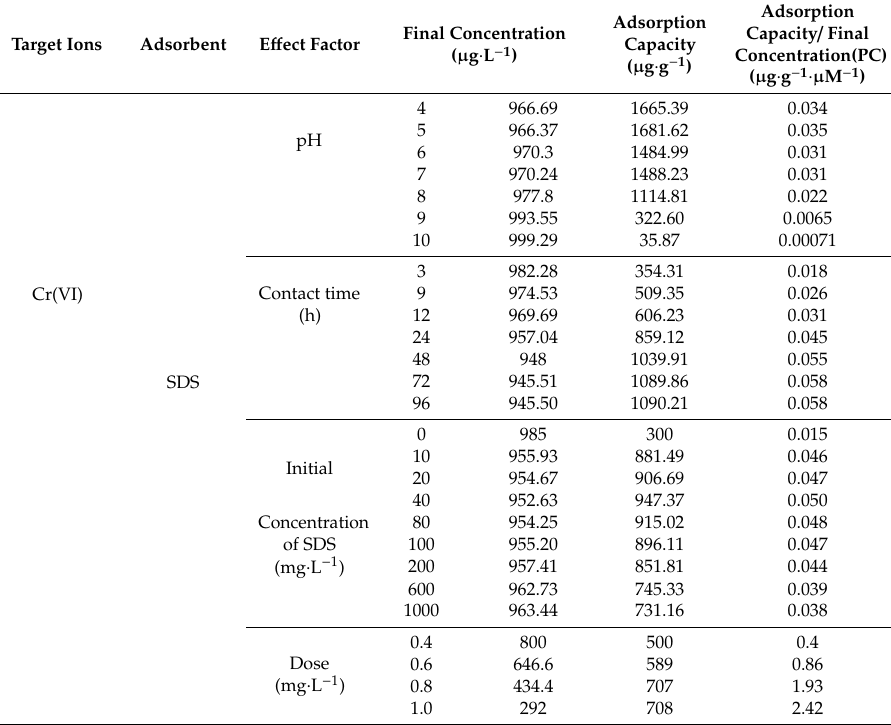
Figure 7. E ff ect of competitive anions on the adsorption of Cr(VI) on the SDS-modified chitosan beads. Table 2. Detailed experimental data of the adsorption process under di ff erent e ff ect